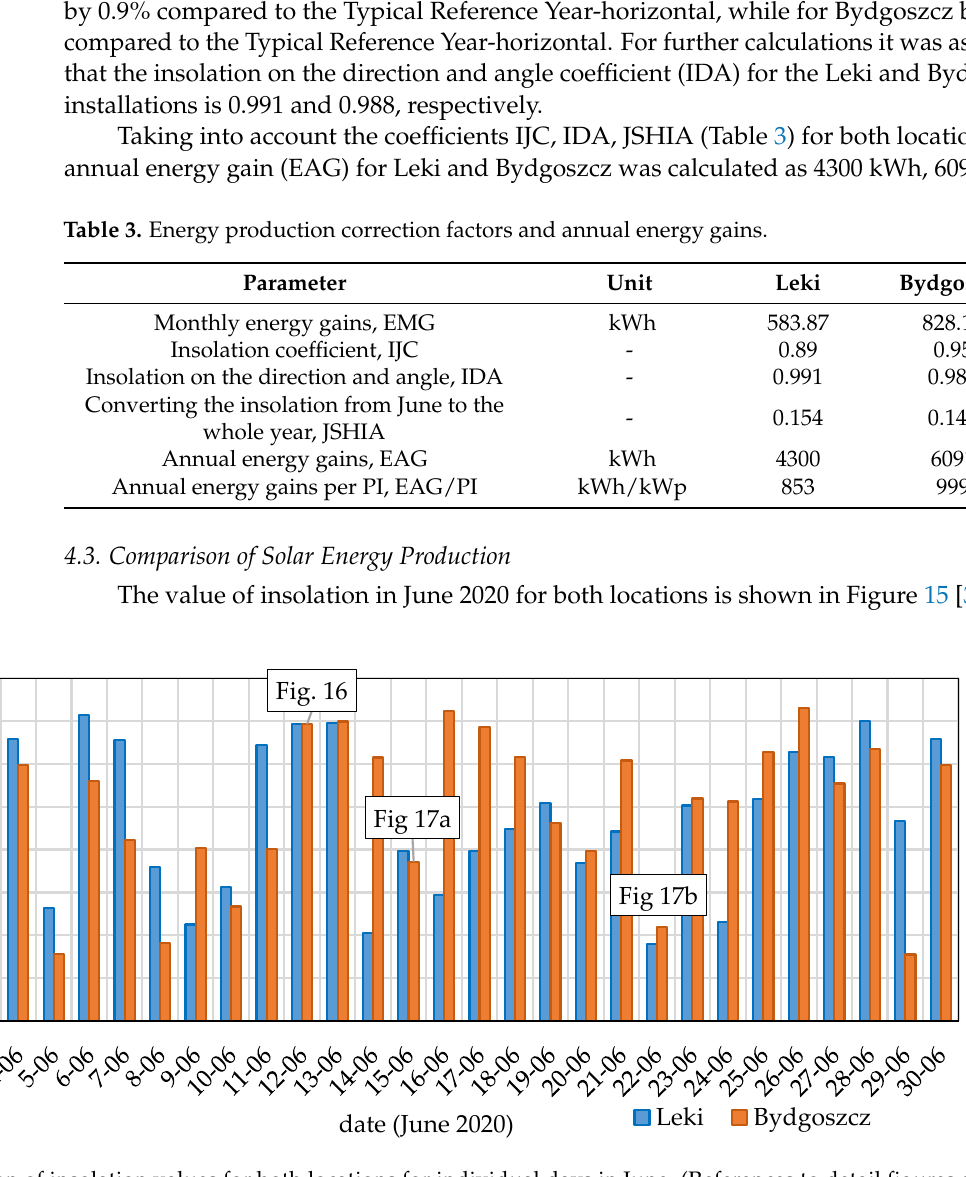
Figure 15. Comparison of insolation values for both locations for individual days in June. (References to detail figures are marked-energy production results for both installations.)